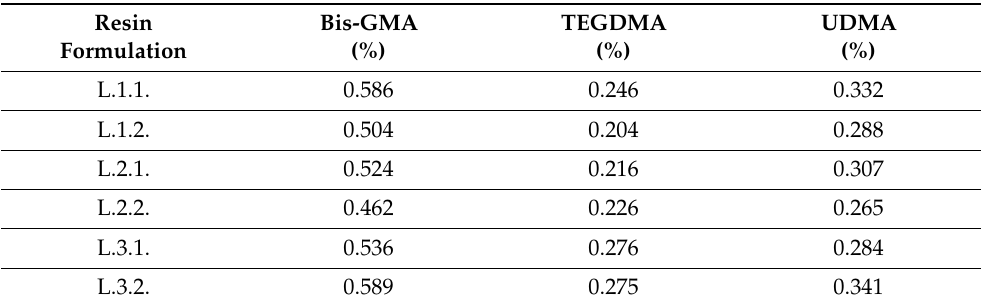
Table 3. Residual monomer amount extracted in acetonitrile and quantified through the calibration curves described